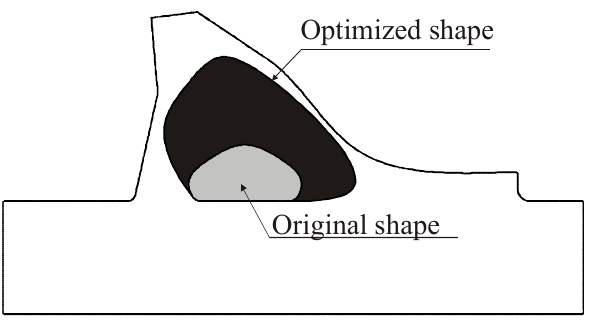
Fig. 13. Gravity dam. Optimized geometry versus